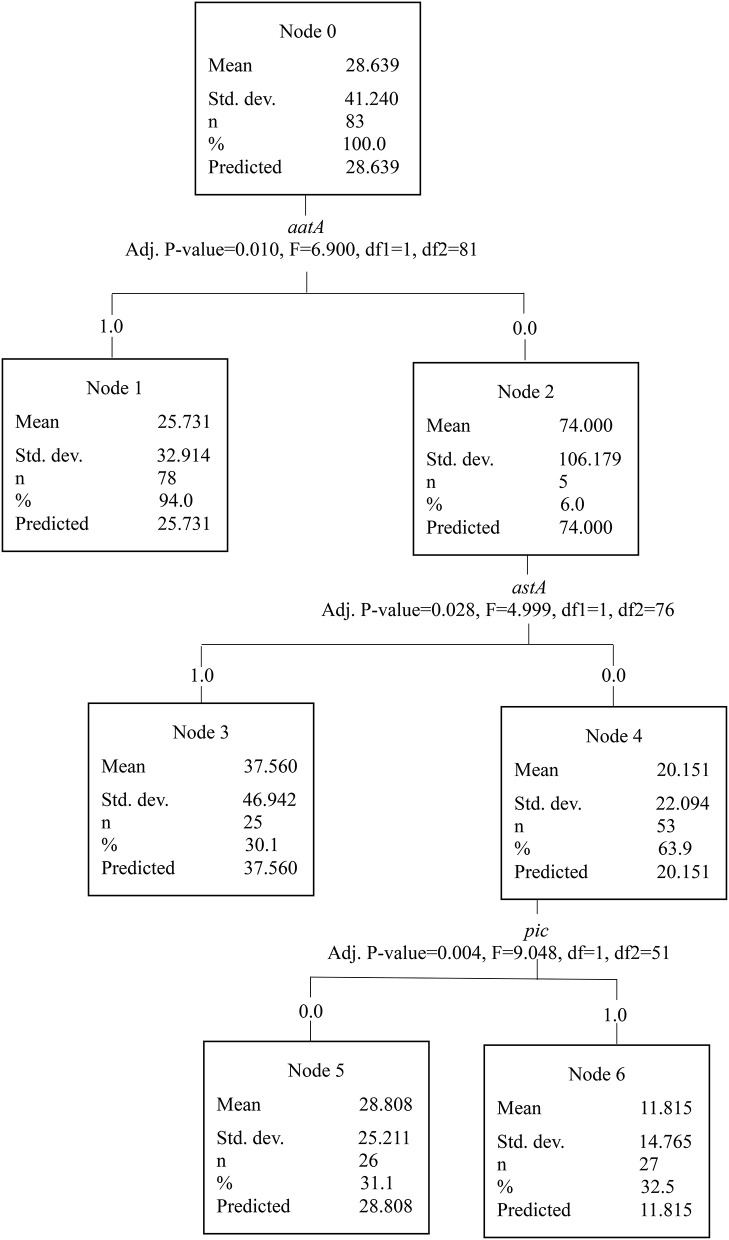
The CART tree analysis shows the affiliations between EAEC genes and duration of diarrhea treated as continuous data. N is the number of children. The number 0 in each branch indicates the absence of a gene and the number 1 indicates the presence of a gene. The EAEC genes included in the analysis were sat, sepA, pic, sigA, pet, astA, aap, aggR, aaiC, aatA, ORF3, agg3/4C, agg3A, aafA, aggA, agg4A, and agg5. Each branch in the CART tree terminates in a “node,” which represents a specific set of genes, or absence of genes, with a statistical significant association with different durations of diarrhea in days. Strains lacking the aatA gene were associated with diarrhea with the longest median duration (74 days). EAEC strains with the combination of the aatA and astA genes were associated with prolonged diarrhea with a higher median duration (38 days) compared with EAEC strains lacking the astA gene and presence or absence of the pic gene (29 and 12 days, respectively).